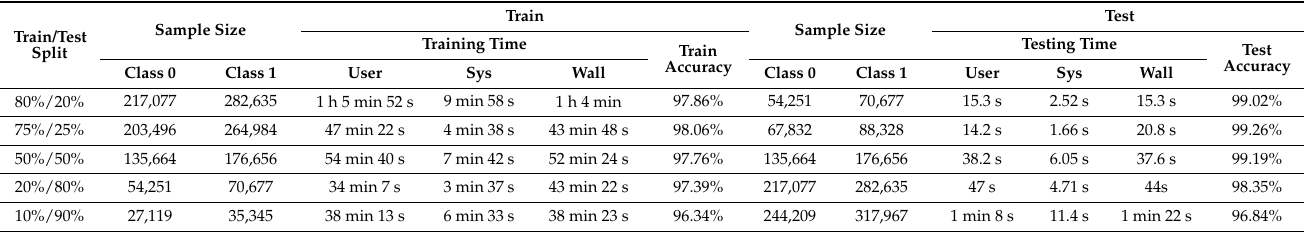
Table 12. Accuracy with different train/test splits and their effect on time.